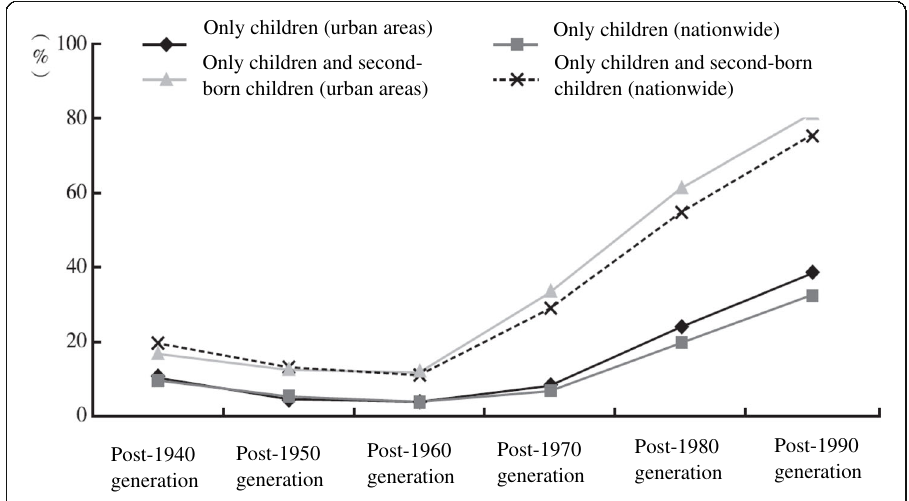
Fig. 1 Generational disparities in the proportions of single children and second-born